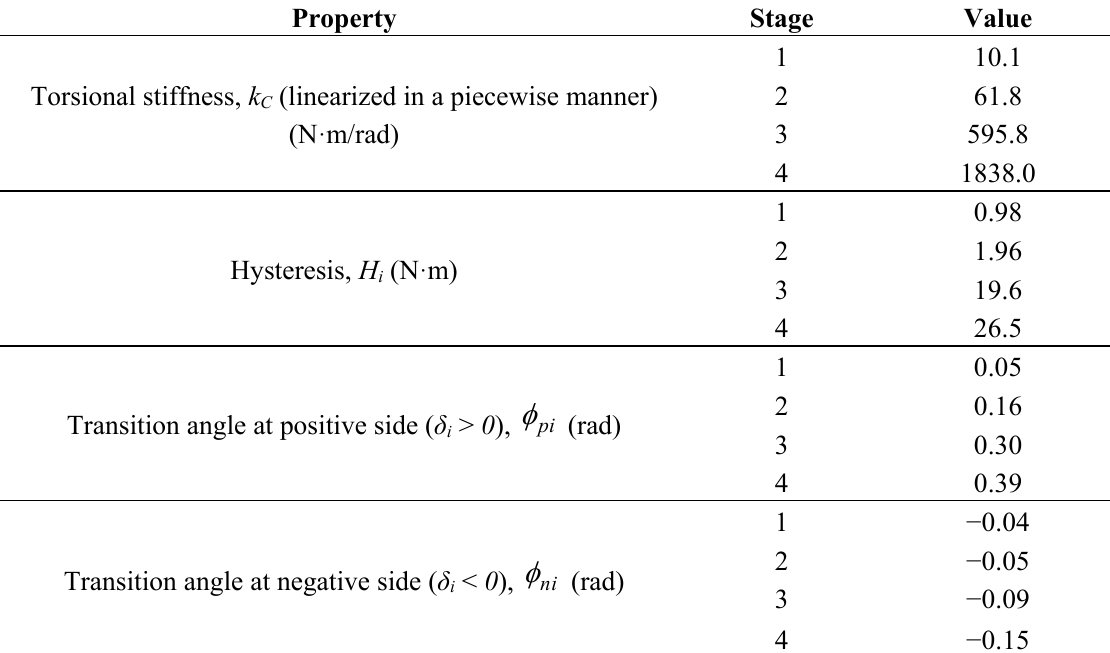
Table 1. Properties of the practical multi-staged clutch dampers.